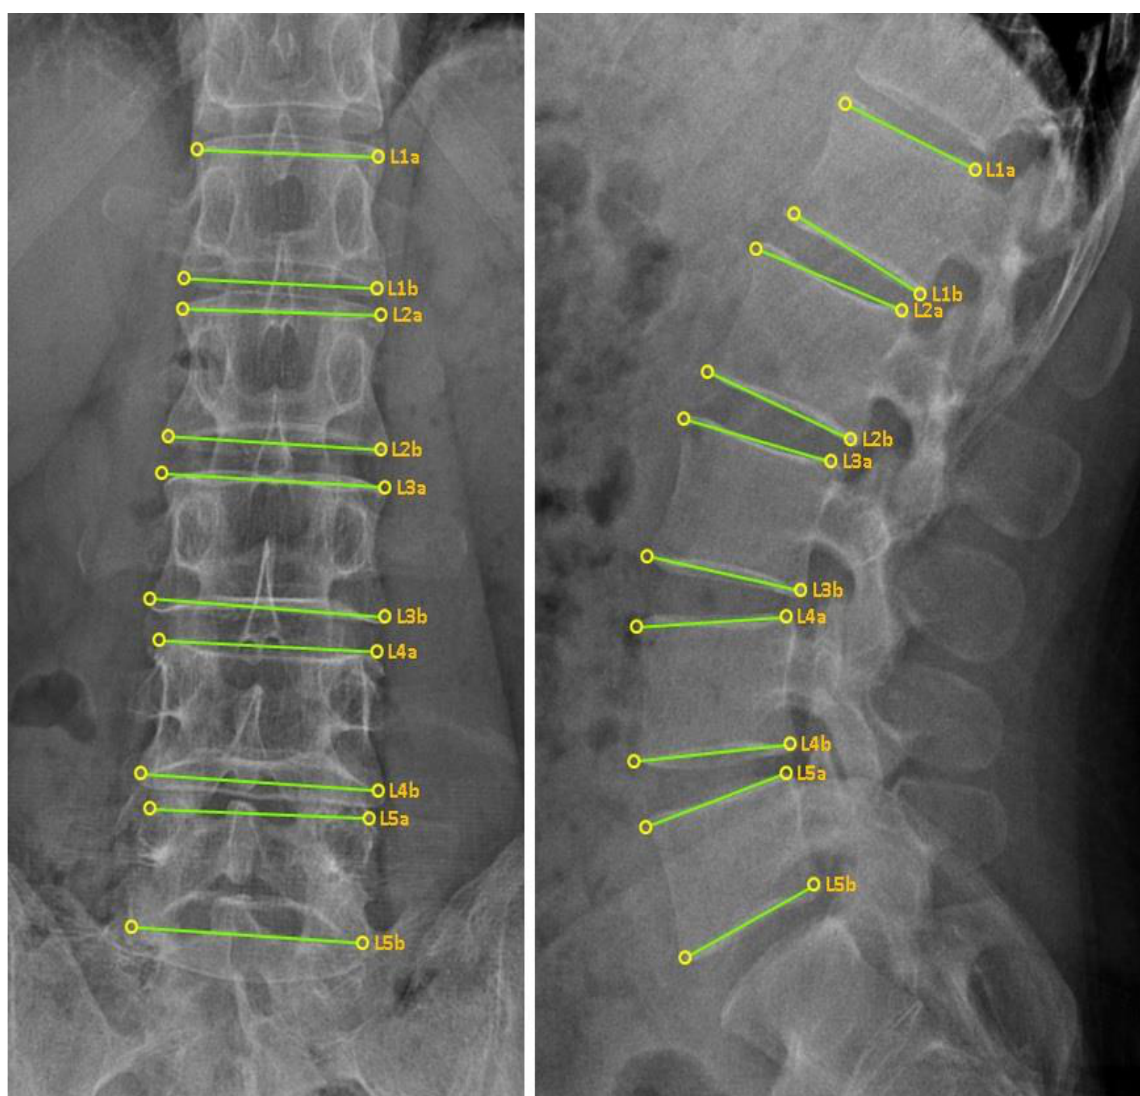
Figure 4. Example of the feature point locations suggested by the CMT-AI program. CMT, Chuna manual therapy; AI, artificial intelligence